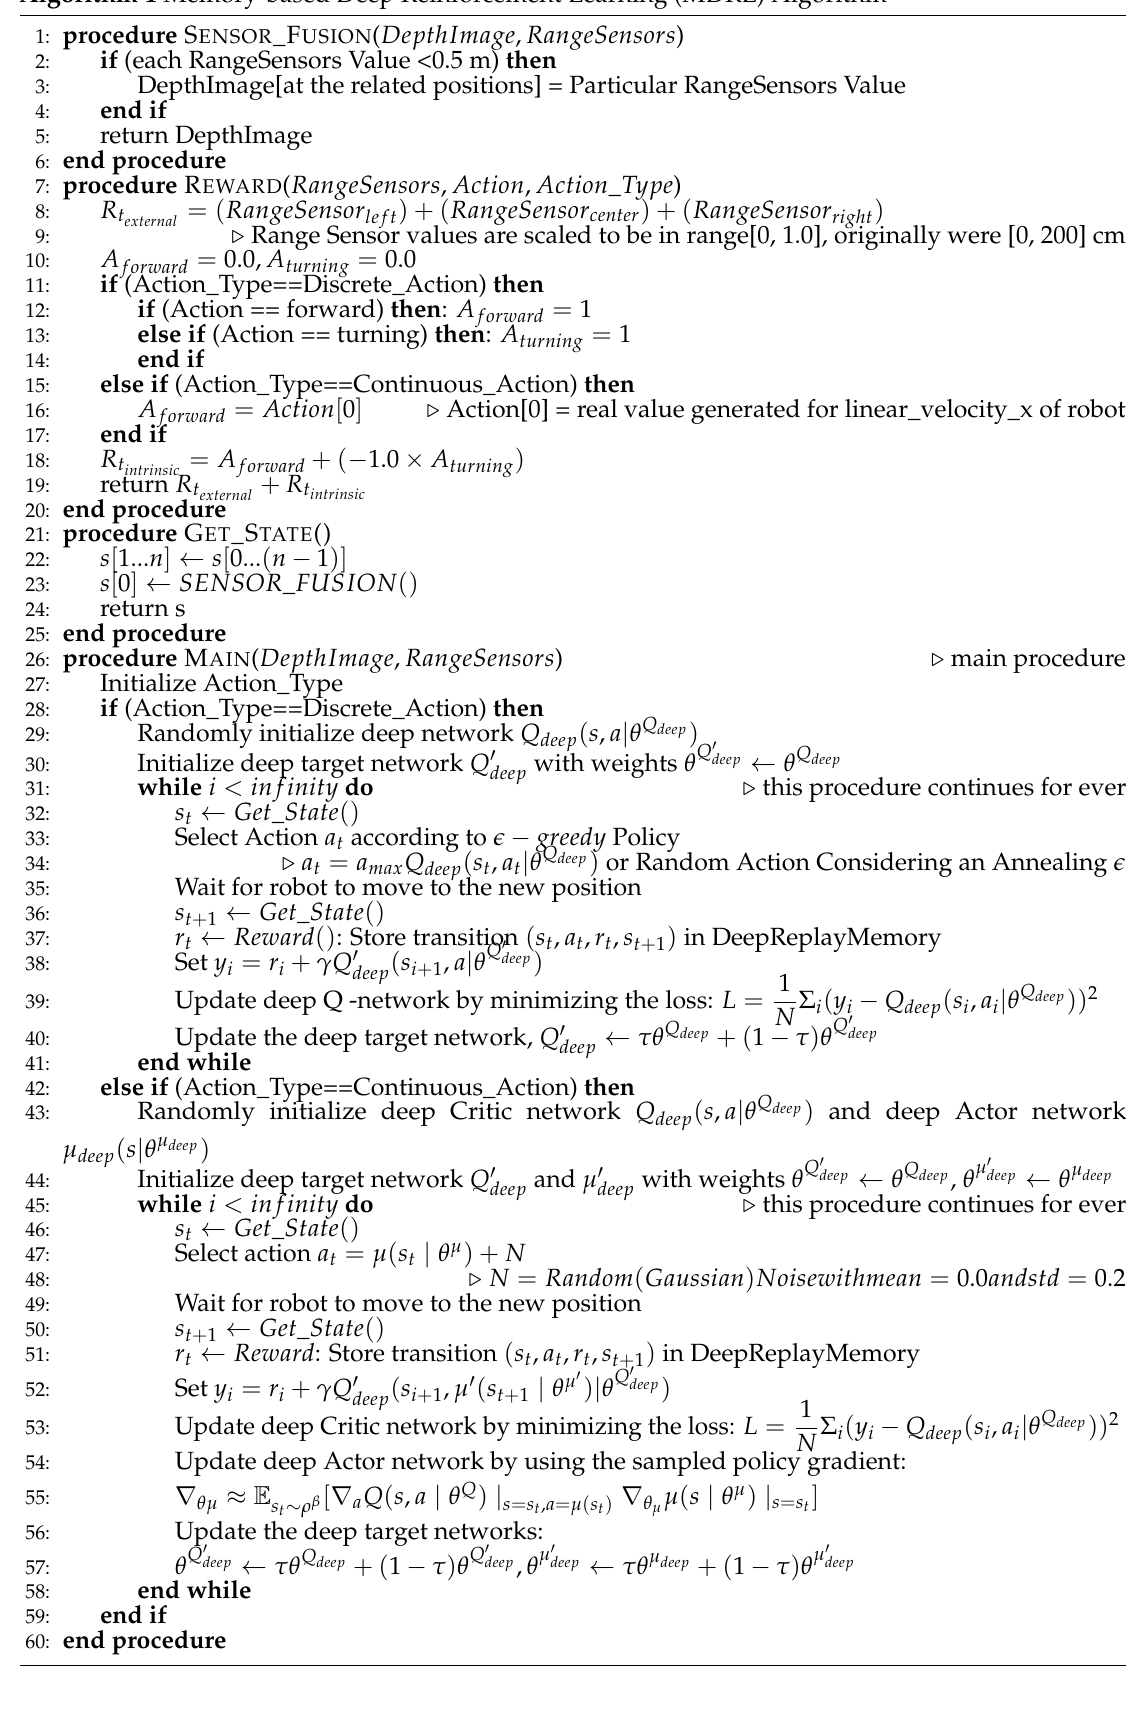
Algorithm 1 Memory-based Deep Reinforcement Learning (MDRL)